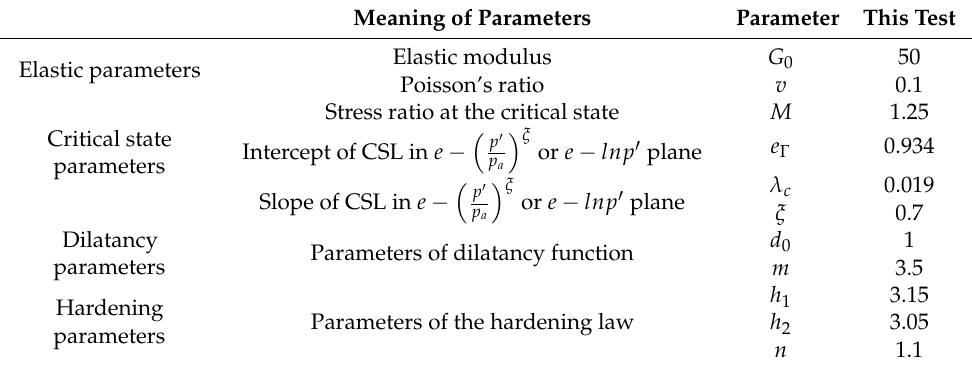
Table 1. Model parameters of state-dependent saturated sand in Wang’s test.